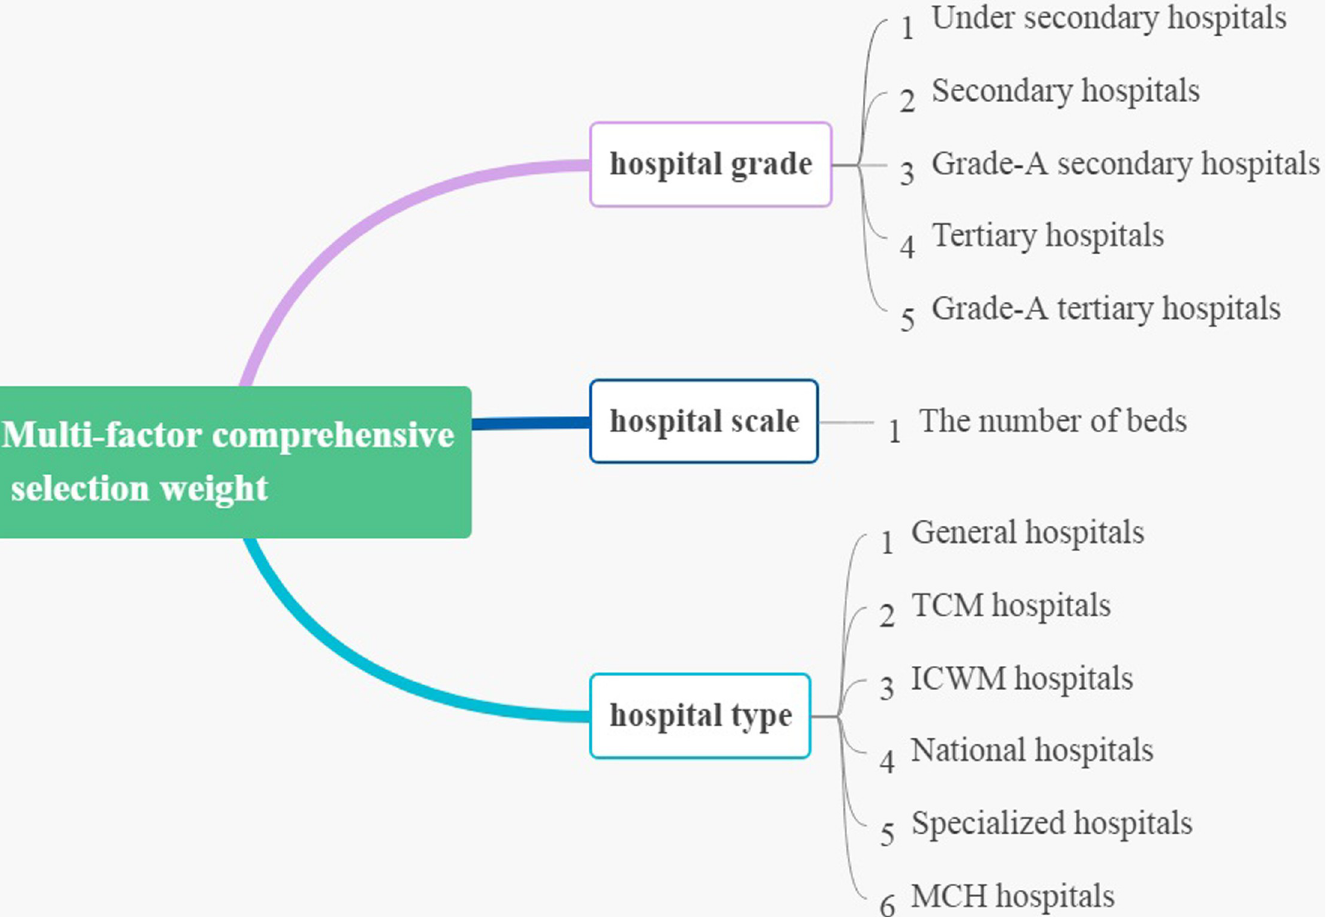
Fig 1. Constructed multi-factor comprehensive selection weights.